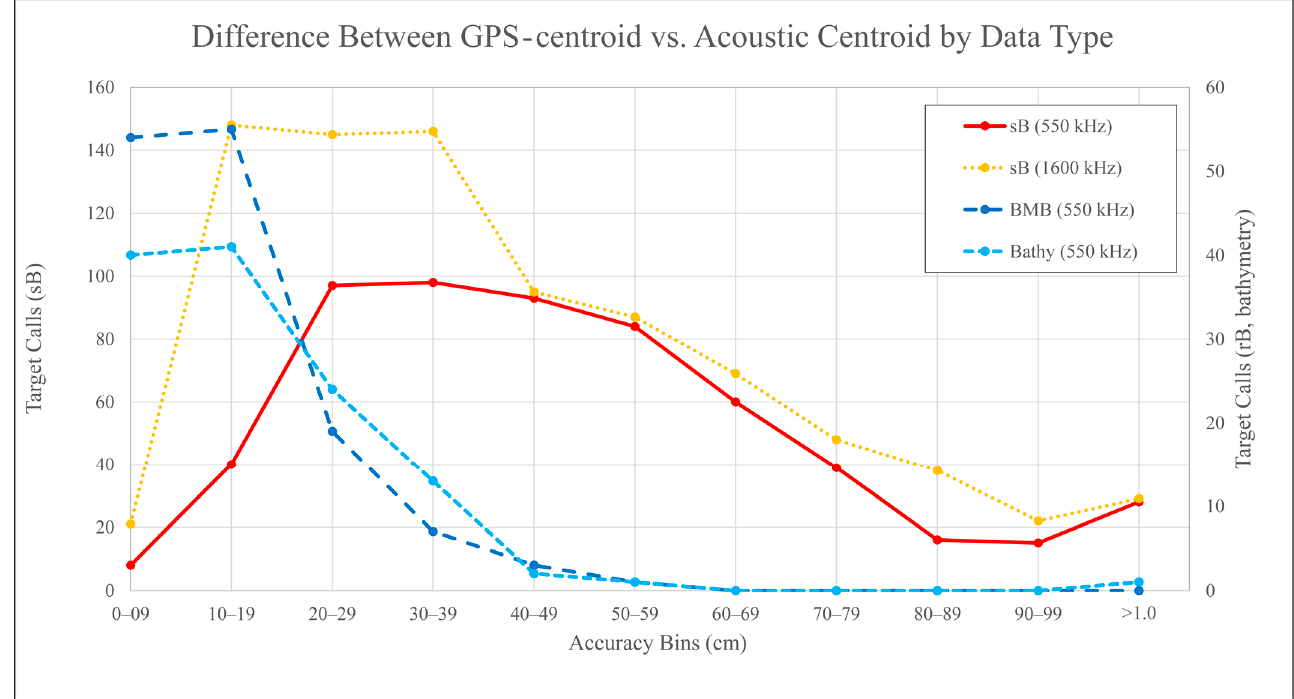
Figure 5. Difference between the GPS centroid and acoustic centroid in 10 cm bins for all acoustic data types (n = 1867). sB = sidescan backscatter (550 kHz, n = 578; 1600 kHz, n = 848), BMB (change figure inset) = bathymetry-mode backscatter (n = 139), Bathymetry (n = 122).